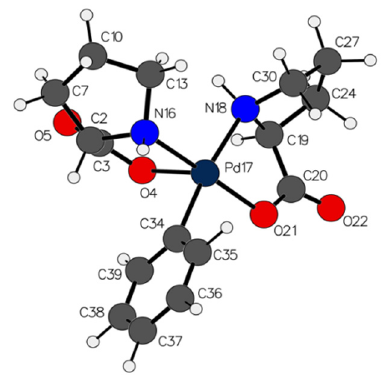
Figure 15. DFT-optimized geometry of the transmetallated intermediate. The non-occluded lobe of the d z2 orbital projects out of the page towards the reader.